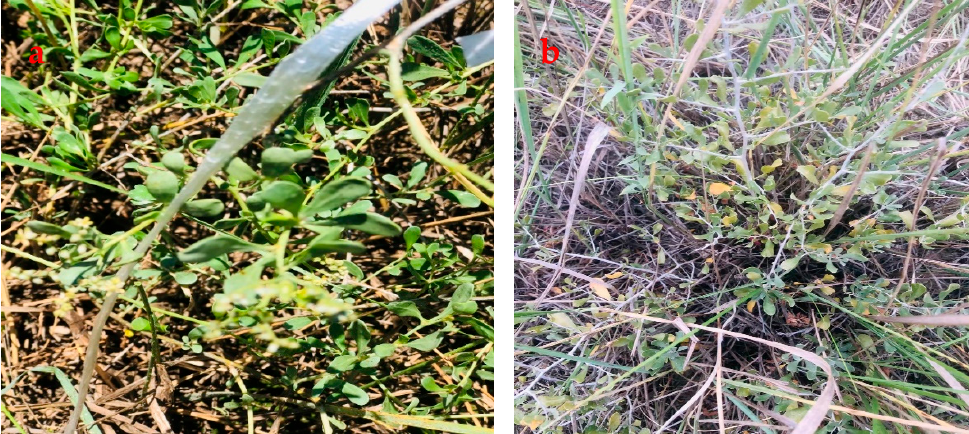
Figure 4. ( a ) Picture of selected Nitraria tangutorum shrubs at the maturation stage from the experimental site before coppicing and ( b ) picture of selected Nitraria tangutorum shrubs from the experimental site after regrowth.